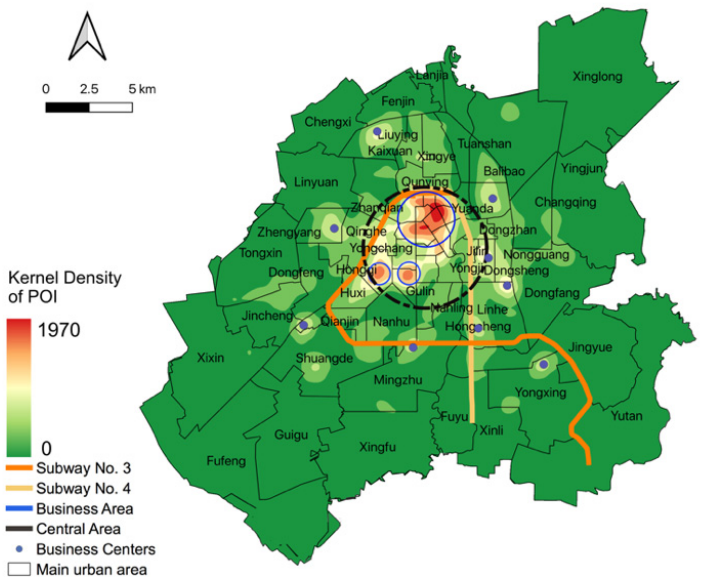
Figure 8. Kernel density of service facilities.